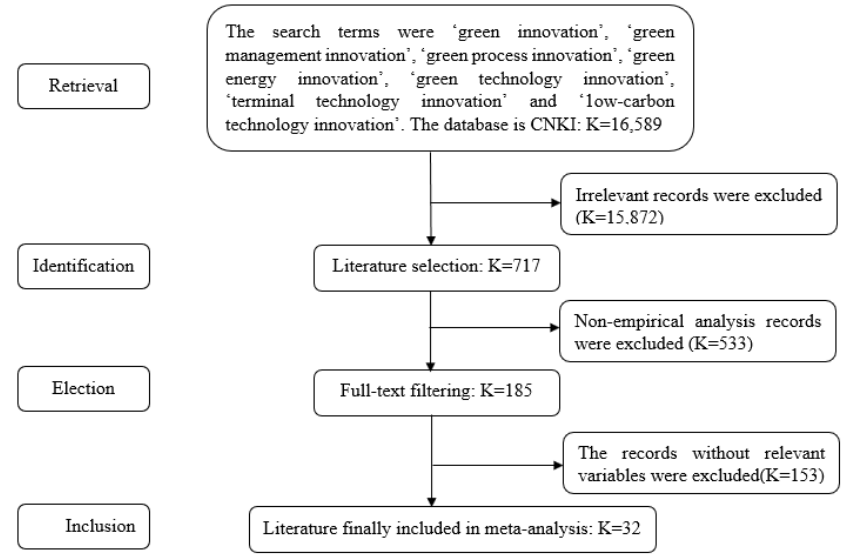
Figure 1. Flow Chart of Document Retrieval and Screening.